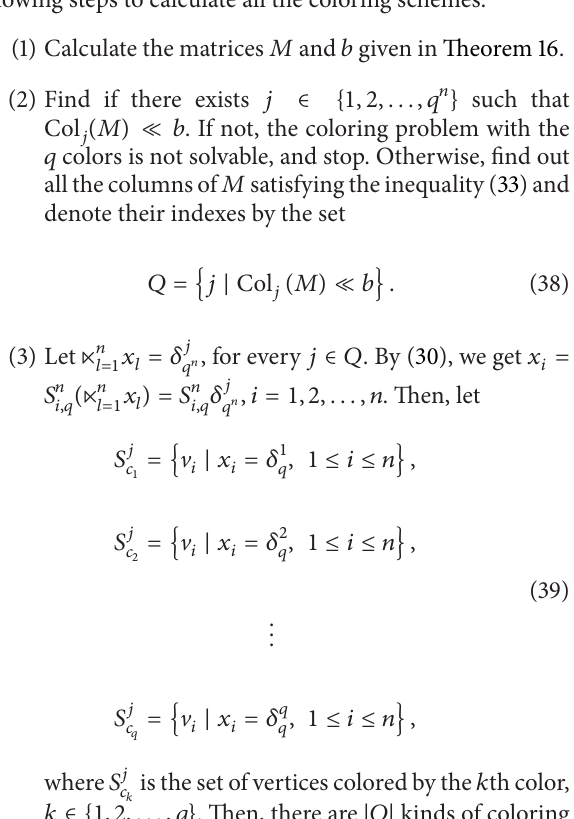
Algorithm 17. Consider the hypergraph 𝐻 and let a color set , 𝑐 , . . . , 𝑐 } . Each vertex V 𝑁 = {𝑐 1 2 𝑞 𝑡 corresponds to a color and, thus, corresponds to a 𝑞 valued CLV 𝑥 𝑡 ∈ Δ 𝑞 . We give the following steps to calculate all the coloring